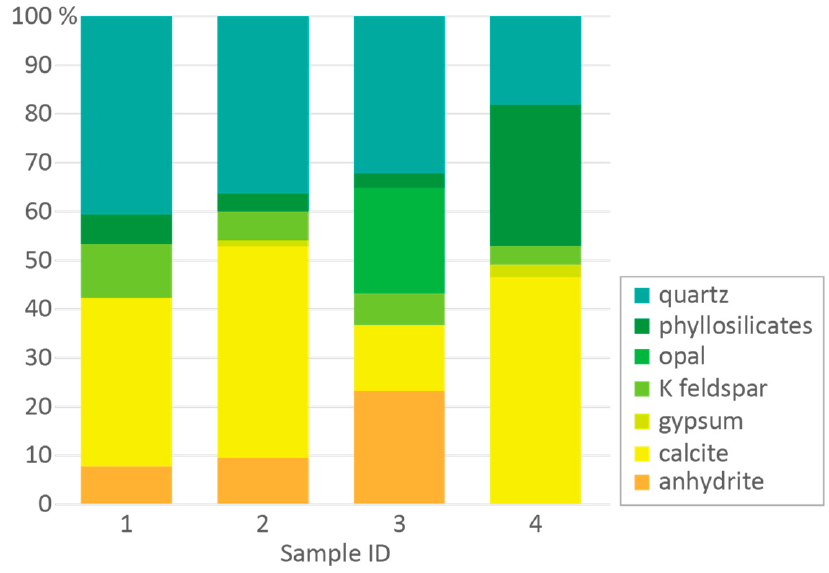
Figure 3. Mineral phases identified on rhizosphere soils (relative quantification, in %). Soils PTEs (Table 2) revealed significant differences (one sample t -test; p < 0.05) be- tween samples Cr, Fe, Mn, Ti, and Zr content. The cluster analysis formed two major groups, one with sample R1 and another with samples R2 and R4, revealing an associ- ation to mean background values, and these three variables were grouped with sample